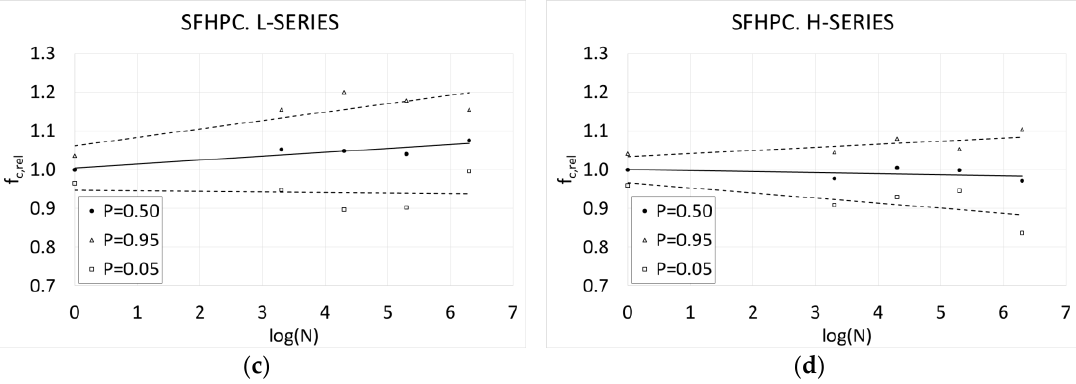
Figure 5. Variation of compressive strength by number of cycles. SFHPC ( a ) L-Series. Raw values. ( b ) H-Series. Raw values. ( c ) L-Series. Maximum, minimum, and average relative values, and tendency lines. ( d ) H-Series. Maximum, minimum, and average relative values, and tendency lines.